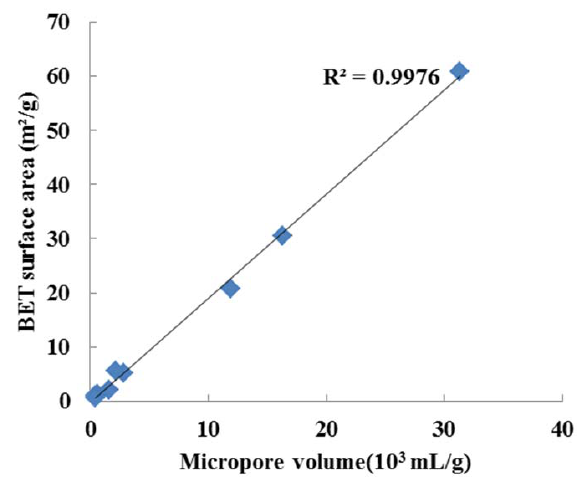
Figure 1. BET surface areas versus micropore volume of